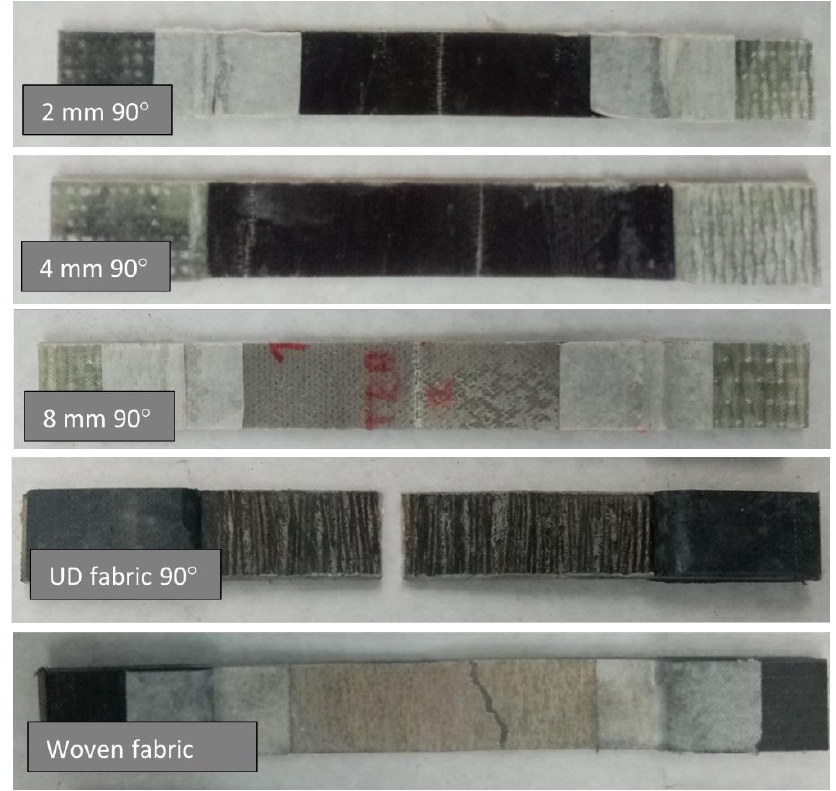
Figure 10. Samples of the 90° variant after the break.